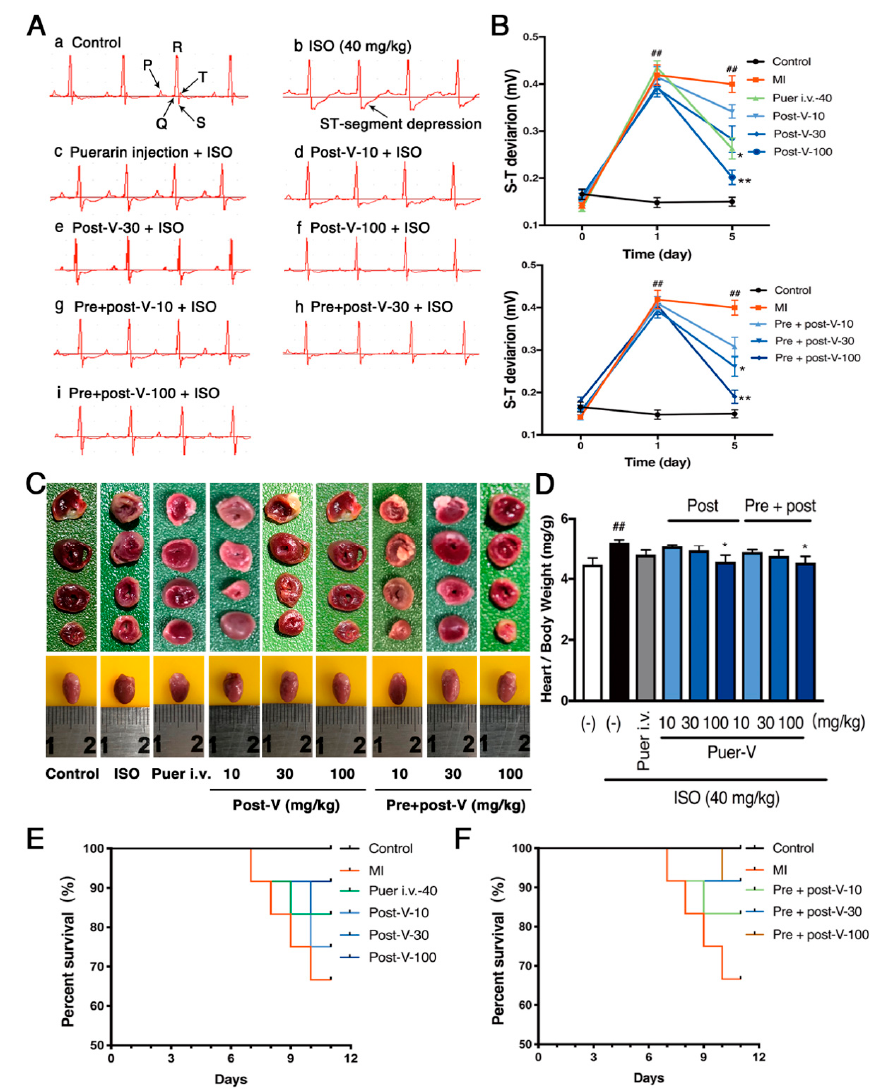
Figure 2. Cardioprotective effects of puerarin-V in the MI mice. ( A ) Representative images of ECG. (a)–(i) correspond to groups: (a) control group; (b) model group at day 5 after the MI induction; (c) puer i.v.-40 mg/kg group at day 5 after the MI induction; (d), (e) and (f): post-puerarin-V groups (10, 30, and 100 mg/kg, respectively) at day 5 after the MI induction; (g), (h) and (i): pre + post-puerarin-V groups (10, 30, and 100 mg/kg, respectively) at day 5 after the MI induction. ( B ) Effects of puerarin-V on ST segment deviation (mV) of MI mice. ( C ) TTC-stained heart slices arranged in order and representative images of heart samples from the indicated groups of mice are shown in the photos. The white area represents infarcted tissue. ( D ) The heart wet weight/body weight ratio in each group. ( E , F ) The survival rate of MI mice and normal mice in each group. All mice were observed for mortality until day 6. Data are shown as mean ± SEM (n = 8–10). ## p < 0.01 vs control group. * p < 0.05, and ** p < 0.01 vs model group.